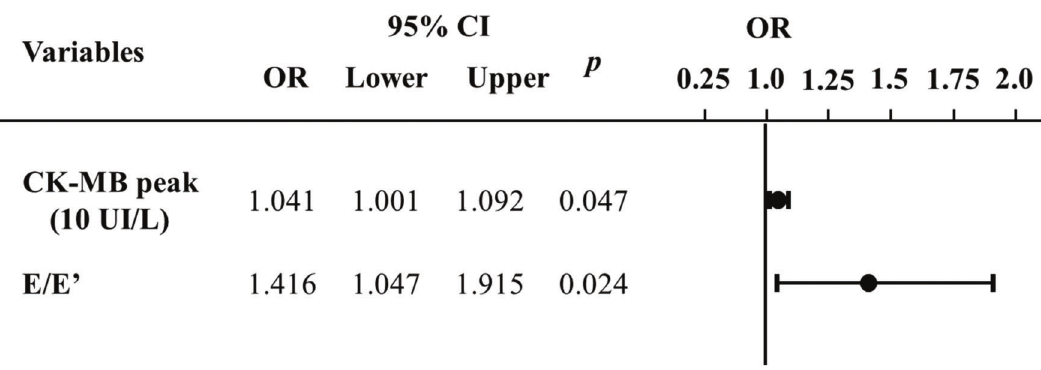
Figure 3 - Multivariate logistic regression to predict ventricular remodeling at 6 months. E: transmitral flow peak velocity in early filling phase; E ’ : the speed of mitral annular diastolic excursion on tissue Doppler in the early filling phase; CKMB, creatinine kinase MB isoenzyme; CI, confidence interval; OR, odds ratio.